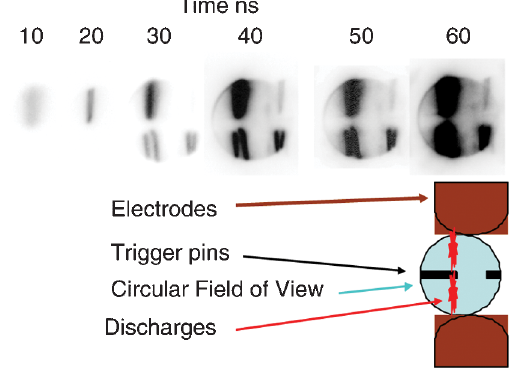
LOW-INDUCTANCE GAS SWITCHES FOR LINEAR . .